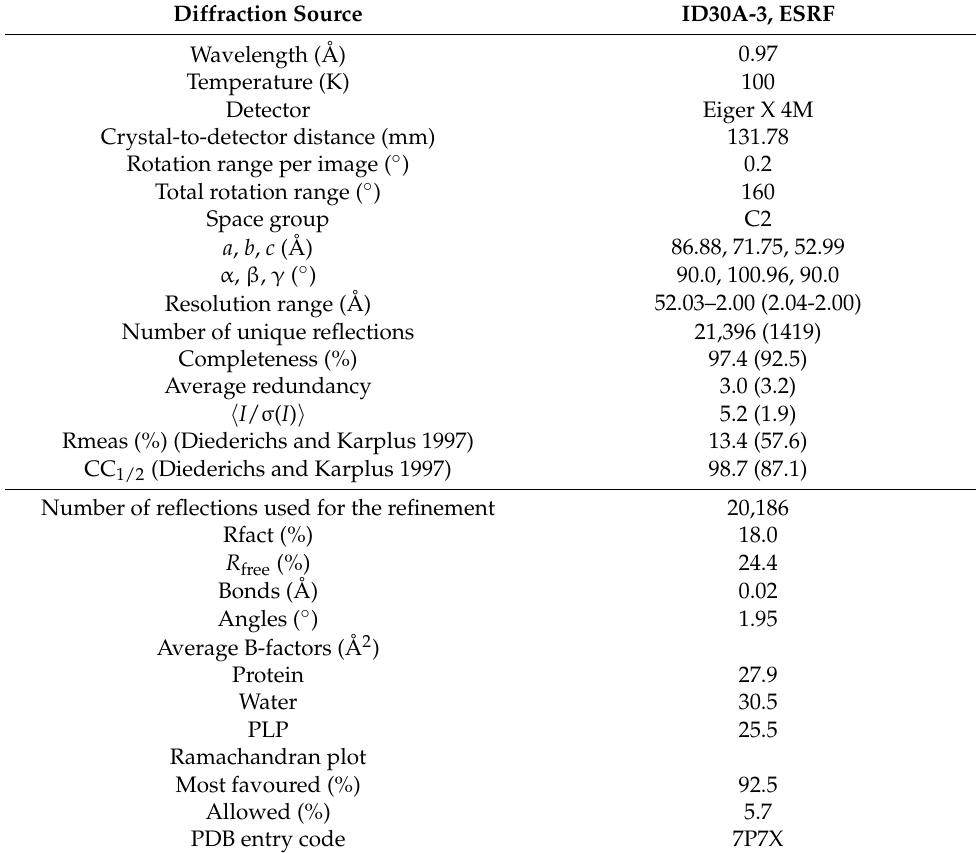
Table 5. Data collection, processing, and